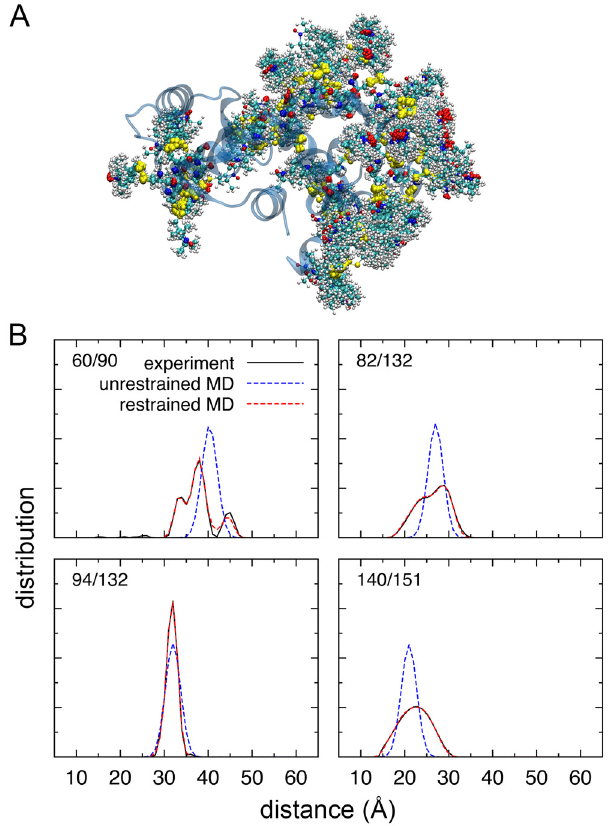
Fig 6. Configurations of the spin-labels attached to T4 lysozyme. (A) A snapshot of the T4 lysozyme system with 34 MTSSL spin-labels. The spin-label at each site has 25 copies and highlighted in the ball-and- stick representation. (B) Distance histograms of four pairs of spin-labels from ESR/DEER experiments (black solid line), and the molecular dynamics simulations without (blue dashed line) and with (red dashed line) an energy restraint. Please see the Supplementary Material, S3 and S4 Figs for the other 47 distance